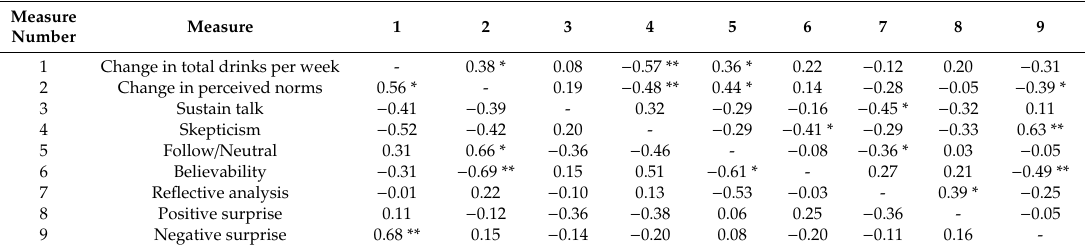
Table 6. Correlation matrix of outcome changes and coding categories for control ( n = 14) and PNF-ATSS ( n = 31).